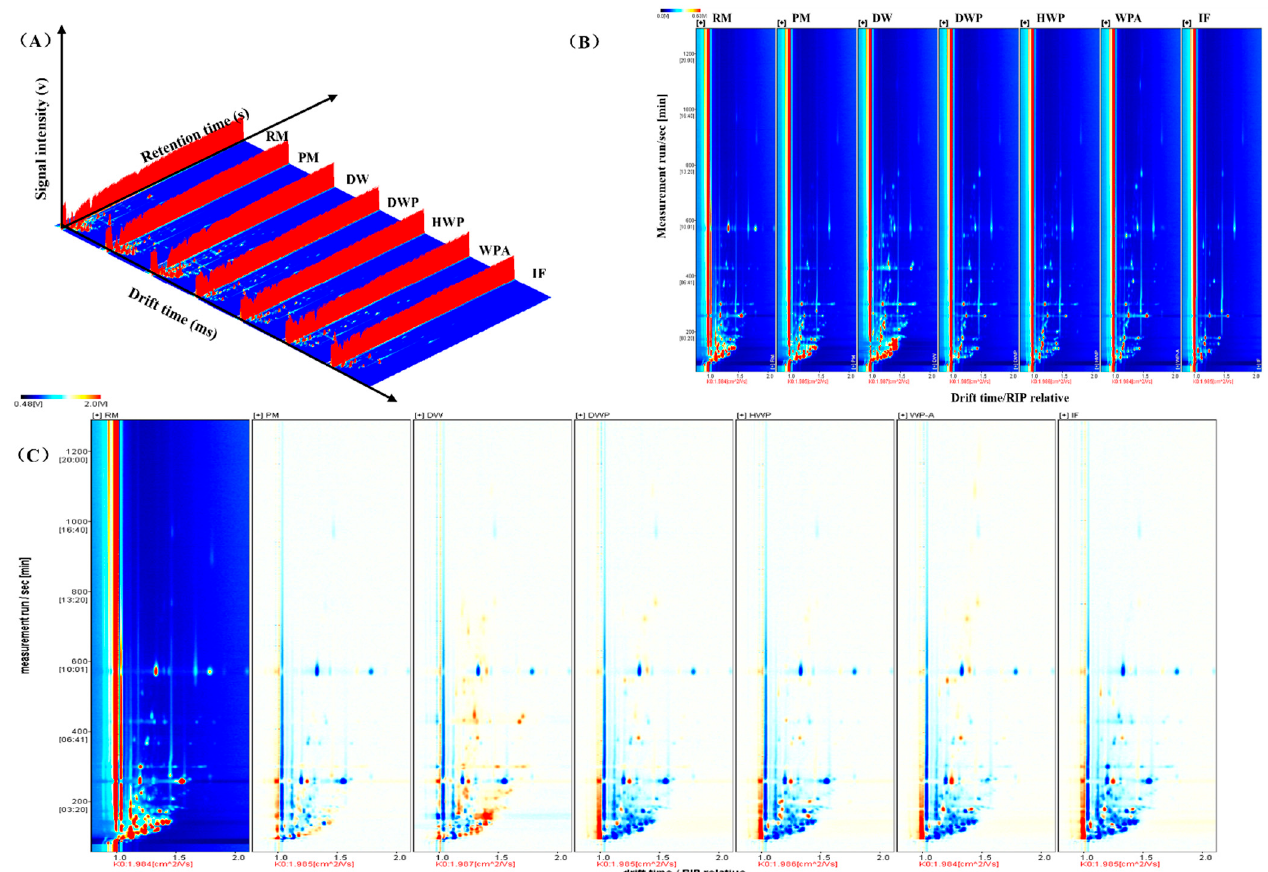
Figure 1. GC-IMS analysis results: ( A ) 3D-topographic, ( B ) topographic plot of GC-IMS spectra, and the ( C ) comparison results under the spectral diagram. RM, raw milk; PM, pasteurized milk; DW, demineralized whey; DWP, demineralized whey powder; HWP, hydrolyzed whey protein powder; WPA, whey protein powder with added alpha-lactalbumin; IF, infant formula.